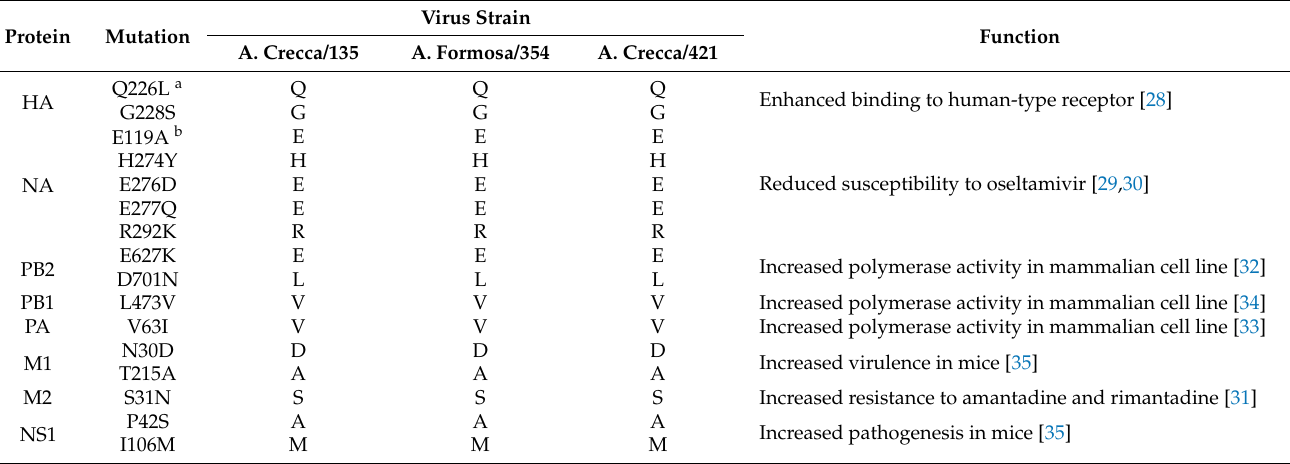
Table 1. Specific amino acid residues analysis of three H12 IAVs identified from wild birds in Poyang